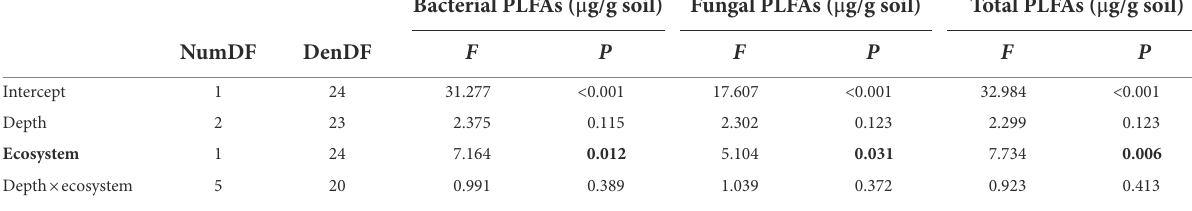
TABLE 1 Variance analysis of phospholipid fatty acid (PLFA) contents for different ecosystems and depths.